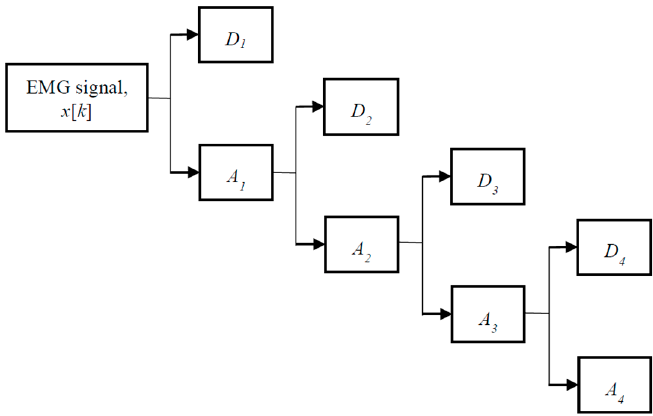
Figure 2. Wavelet decomposition at the fourth decomposition level.